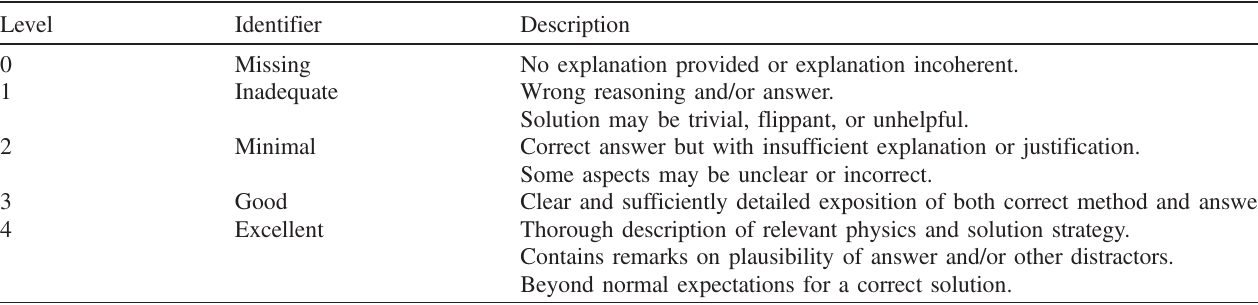
TABLE II. Categorization levels for explanation of solution to